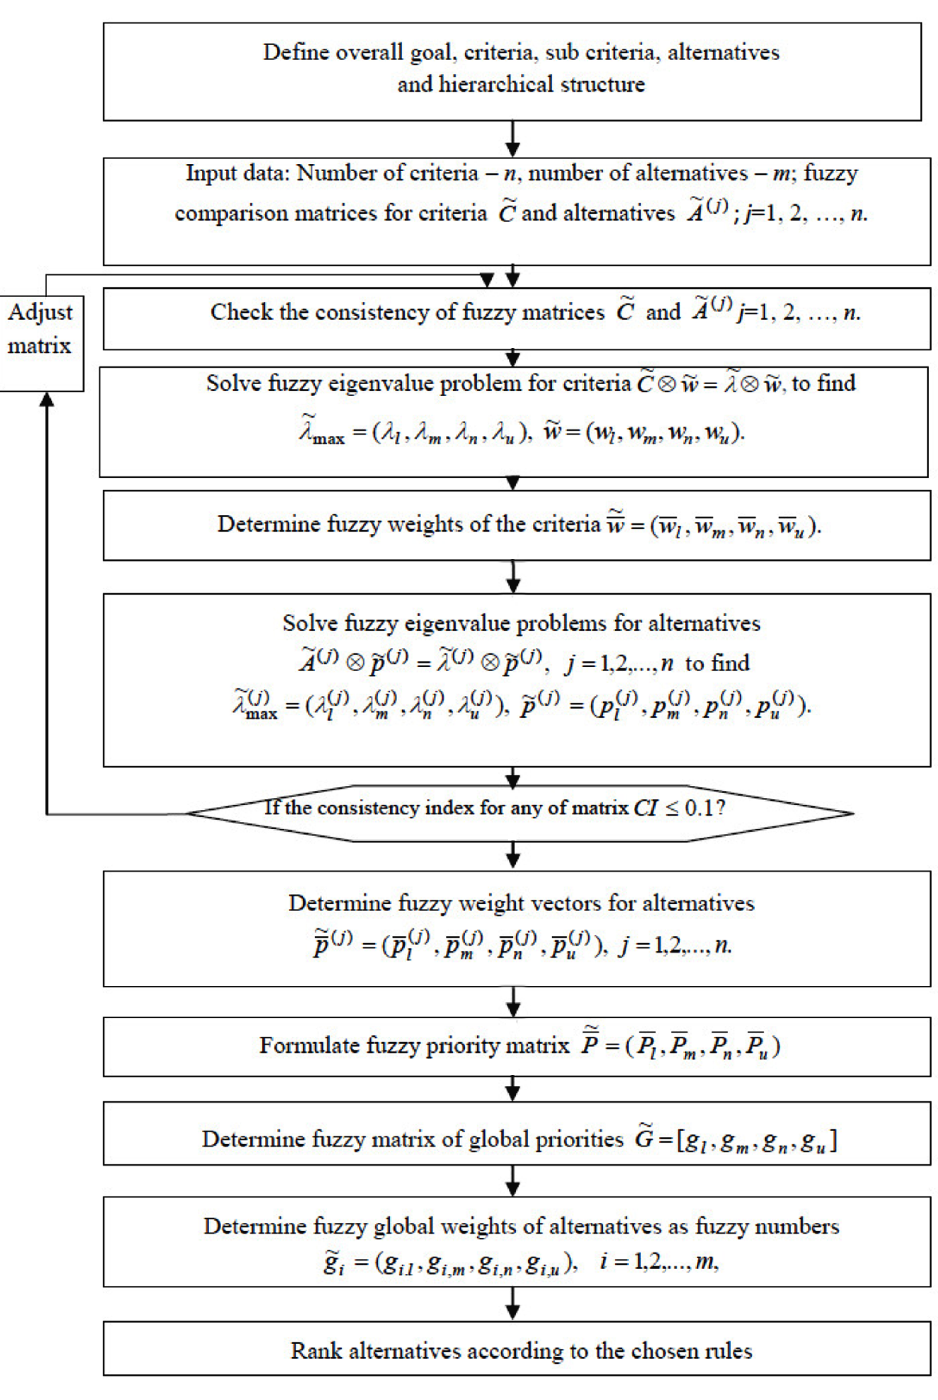
Fig. 2. Fuzzy AHP